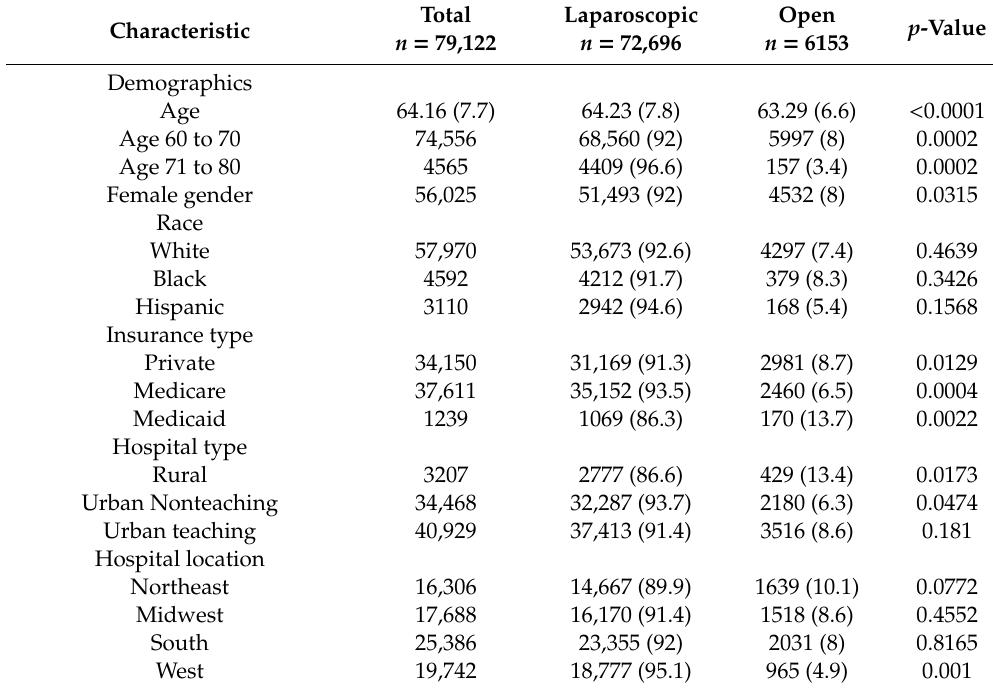
Table 1. Comparison of clinical characteristics between patients undergoing open versus closed bariatric procedures. LOS: Length of stay.